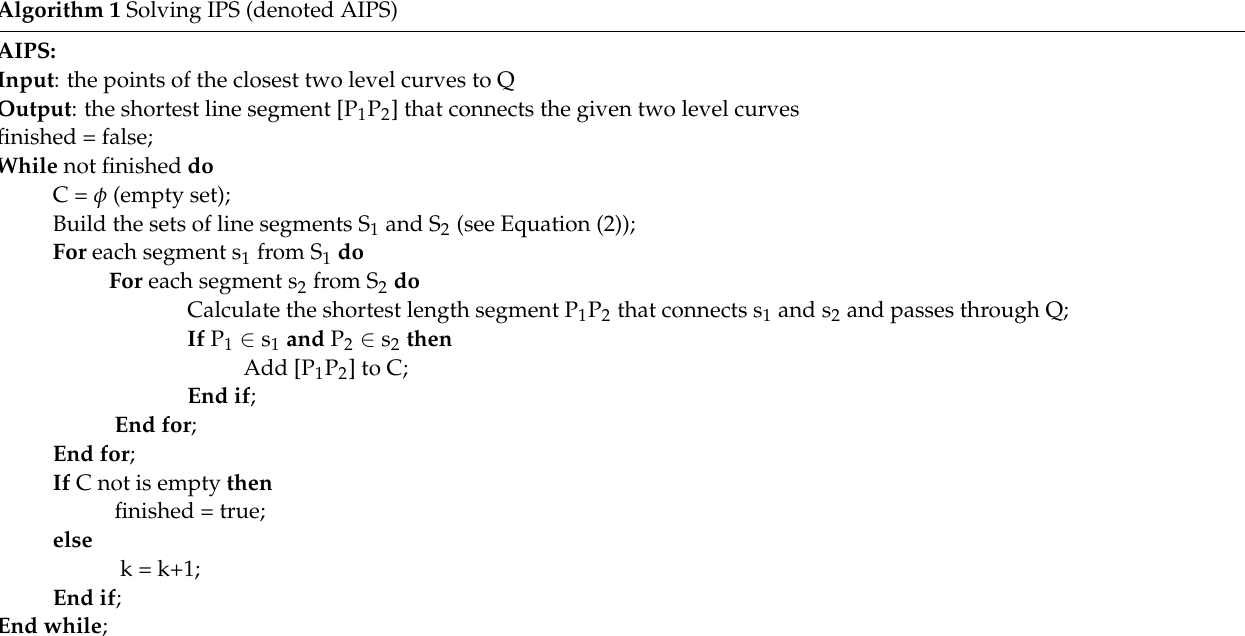
Algorithm 1 Solving IPS (denoted AIPS)